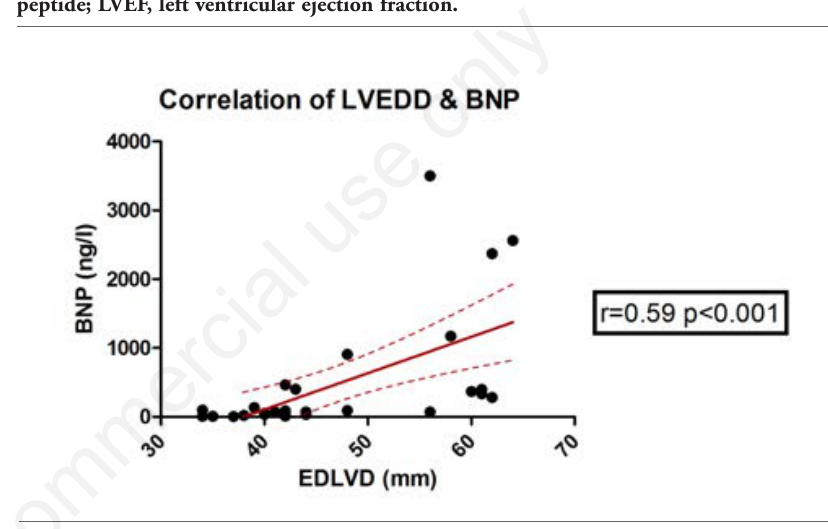
Figure 2. Association between BNP level and EDLVD using linear regression (solid line). The dotted lines represent the 95% confidence band of the best-fit line. BNP, brain natri- uretic peptide; EDLVD, end diastolic left ventricular diameter.